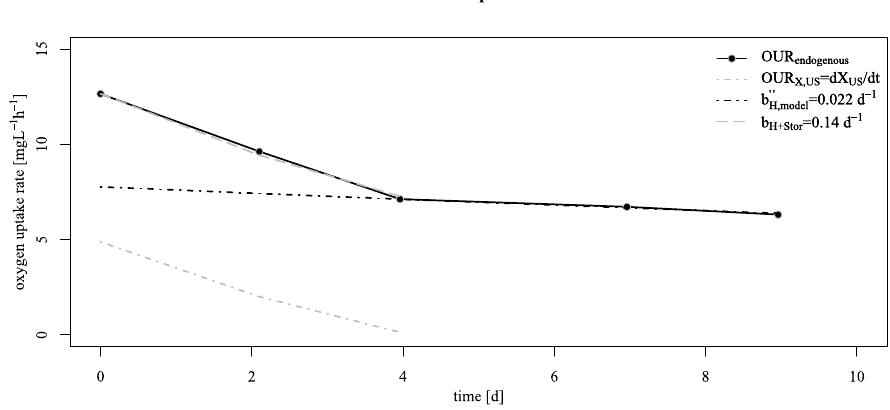
Figure 9. Results of respirometry measurement in a pilot scale trickling filter.